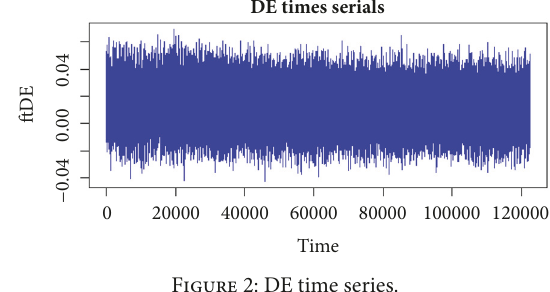
Figure 2: DE time series.